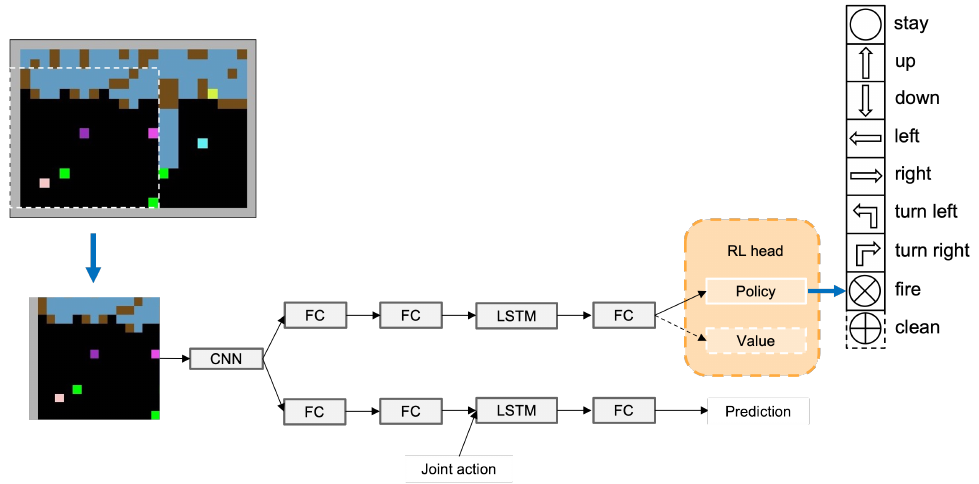
Figure 1. Our network consists of a RL module and a prediction module, which are connected to a convolutional layer. In the baseline, the model contains only the RL module. In the A3C approach, the RL head can learn the RL policy π e and value function V e . In the PPO approach, the RL head only learns the policy π e